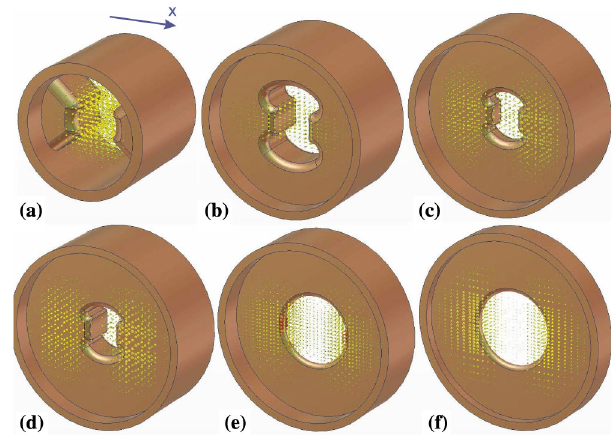
FIG. 3 (color online). Cell geometries and distribution of the electric field in different TDS options. The arrow shows the direction of the deflection x .